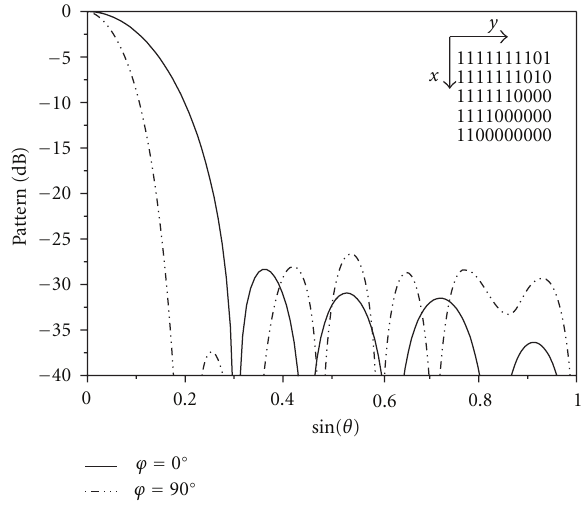
Figure 6: Radiation patterns of the optimized 20 × 10-element planar array with the fitness function as (8).